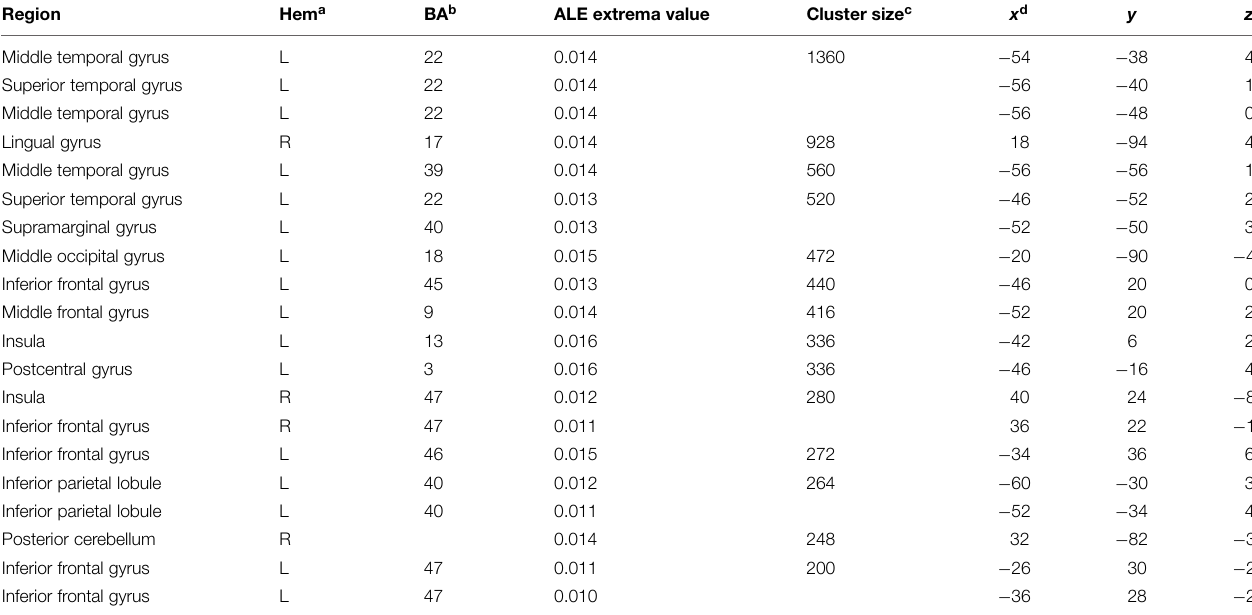
TABLE 4 | Regions showing consistent activations across fMRI studies of verbal creativity. Region